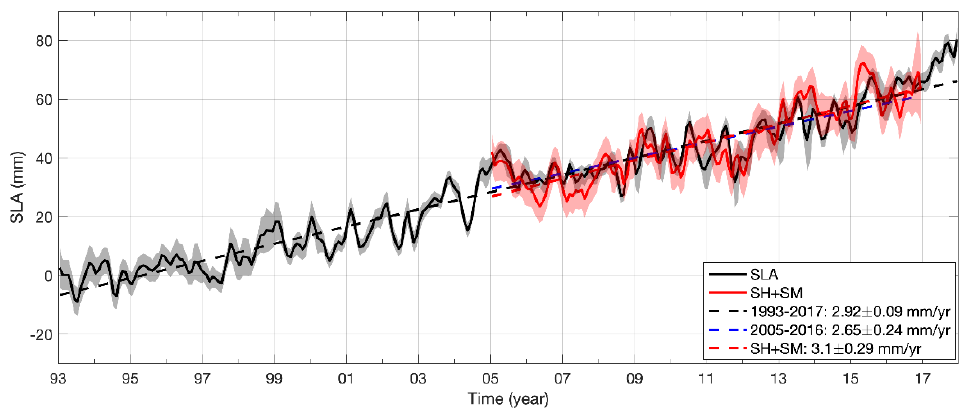
Figure 7. South Atlantic mean sea level (SAMSL) time series without a seasonal cycle derived from altimetry corrected by GIA (SLA: the average of CMEMS and CSIRO) for the period January 1993 to December 2017, and the sum of the components GRACE (SM) and Argo (SH) for the period January 2005 to December 2016. The dashed lines represent the linear regression. The black and red shaded areas represent one standard error. Units: mm.